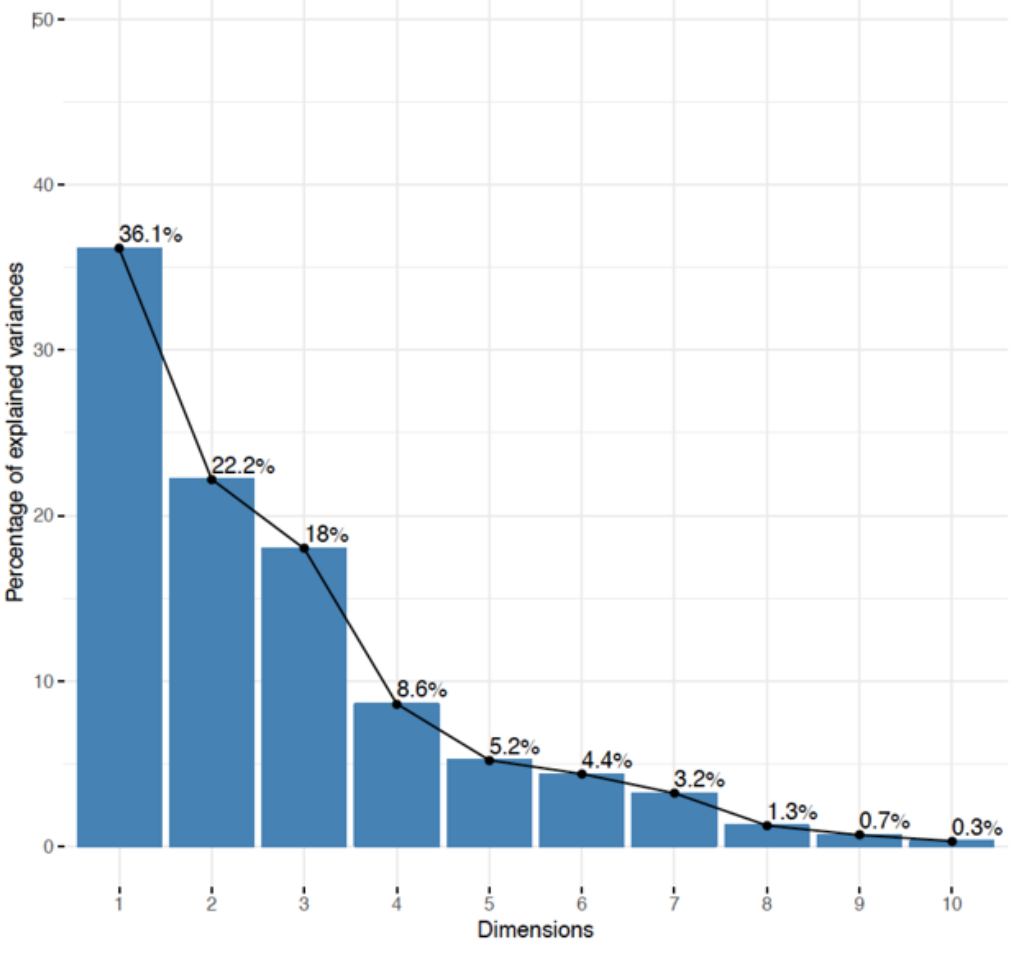
Figure 4. Percentage of variance explained by each of the ten dimensions obtained by PCA analysis of the distributions of quality indicator values.